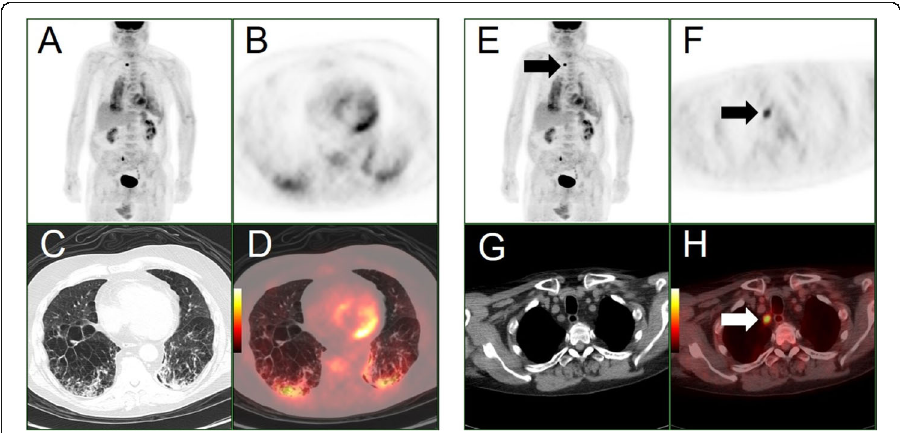
Fig. 3 a PET maximum intensity projection (MIP), b – d : axial attenuation corrected PET, axial CT lung windows and axial fused PET/CT images through the lower thorax. e PET maximum intensity projection (MIP), f – h : axial attenuation corrected PET, axial CT mediastinal windows and axial fused PET/CT images through the superior mediastinum. These images highlight intense bilateral parenchymal metabolic activity, more prominently in the right lower lobe (images a – d ) and high uptake in an ATS station 2R lymph node ( e – h ). Please note spurious right ureteric activity on the MIP images (images a and e